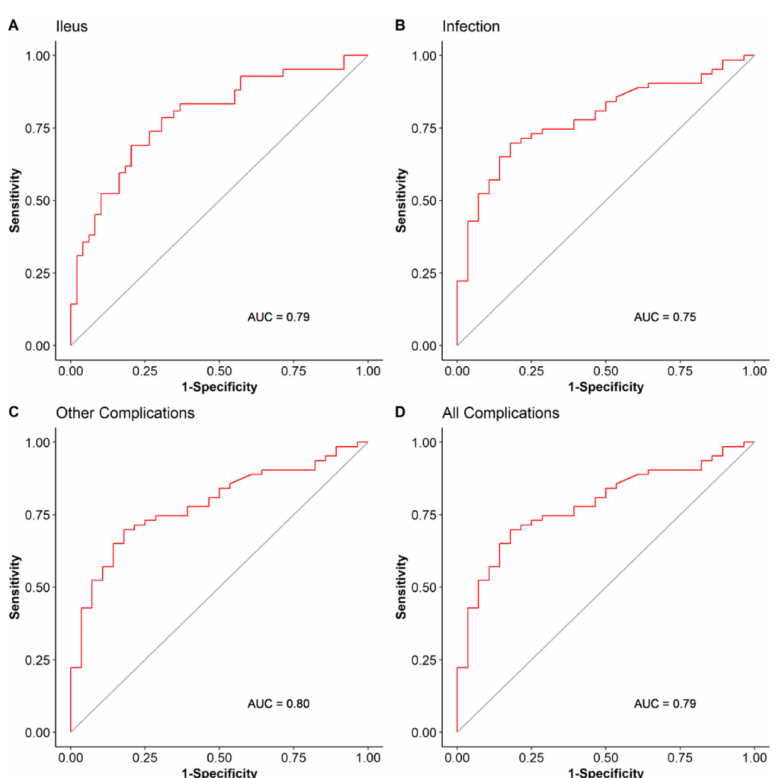
Figure 3. SMI change accuracy in predicting complications in univariable models.